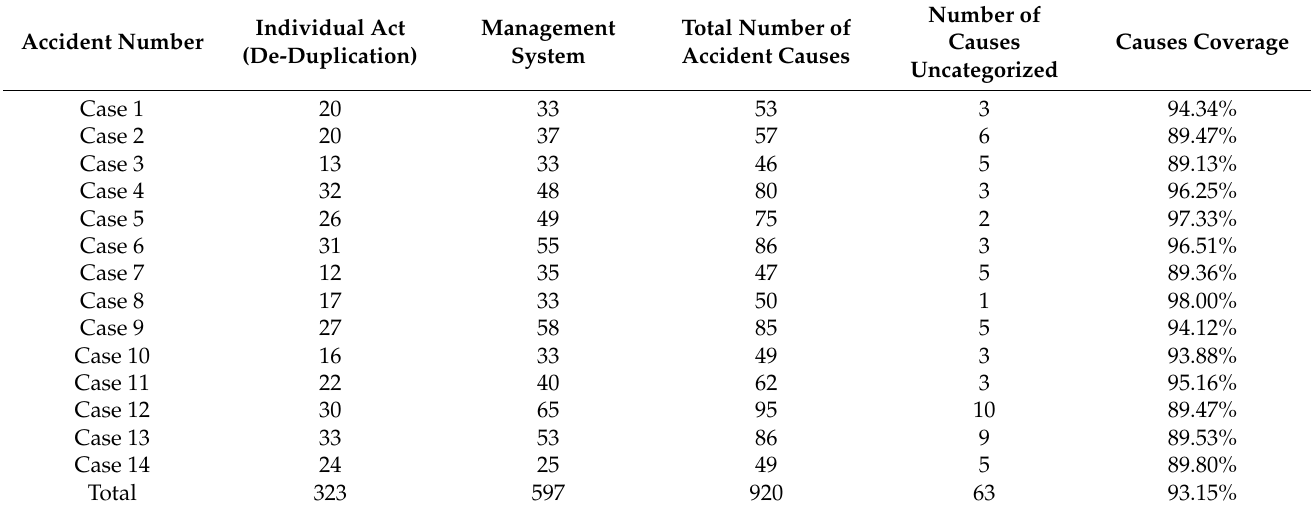
Table 4. Accident cause quantity statistics and causes coverage calculation results (based on accident